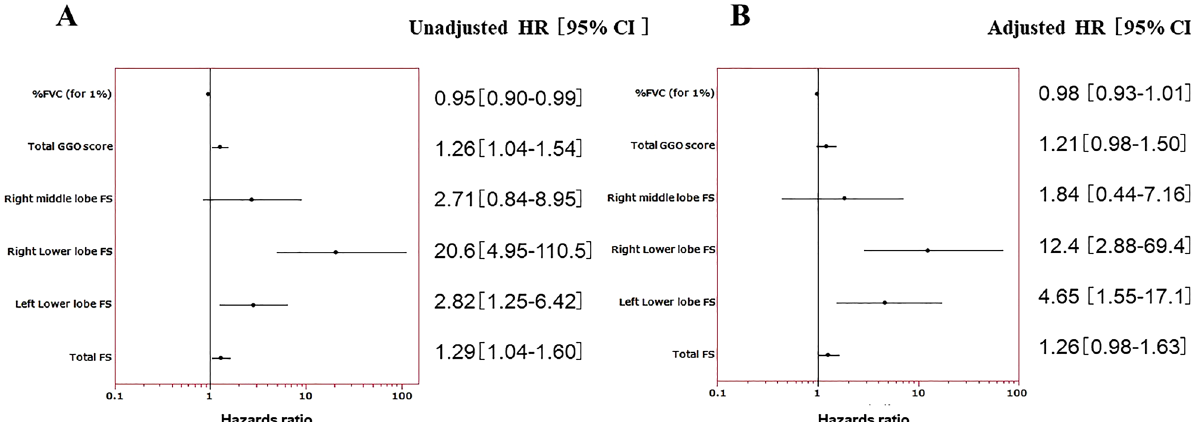
Figure 3. Forest plots analyzing the predictive values of risk factors for respiratory-related death. Solid squares with bars represent the hazard ratios with 95% confidence intervals. ( A ) Univariate analysis with a Cox regression model. ( B ) Multivariate analysis with a Cox regression model using propensity scoring to control for age, sex, smoking history, initial prednisolone dose, and disease duration.